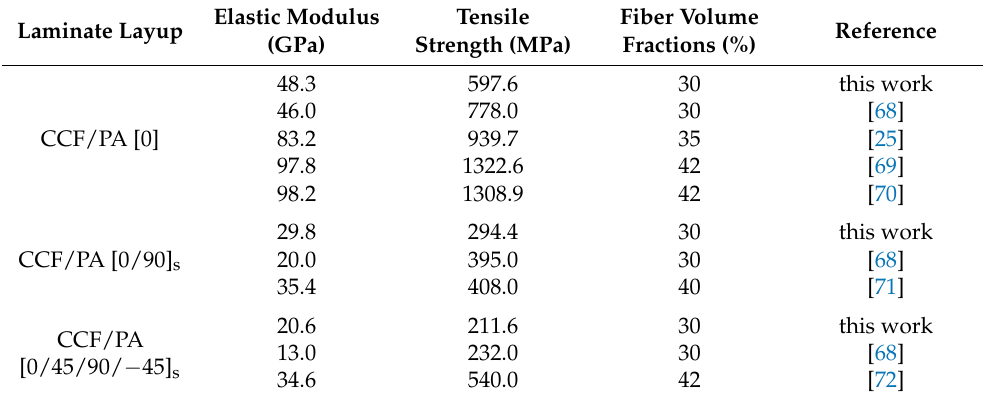
Table 7. Mechanical properties and fibers volume fraction of longitudinal, cross-ply and quasi- isotropic CCF/PA composites produced by FFF and conventional polyamide based laminates manu- factured by hot compression molding